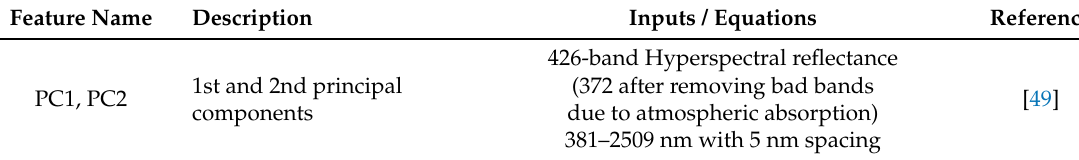
Table 2. Remote-sensing-derived features to train random forest models for species